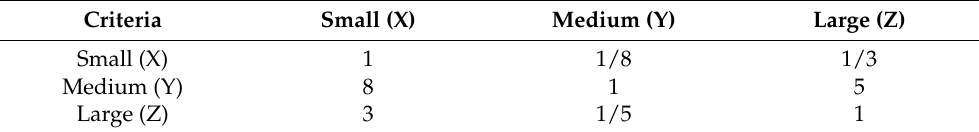
Table 15. Complete comparison matrix A5. Criteria